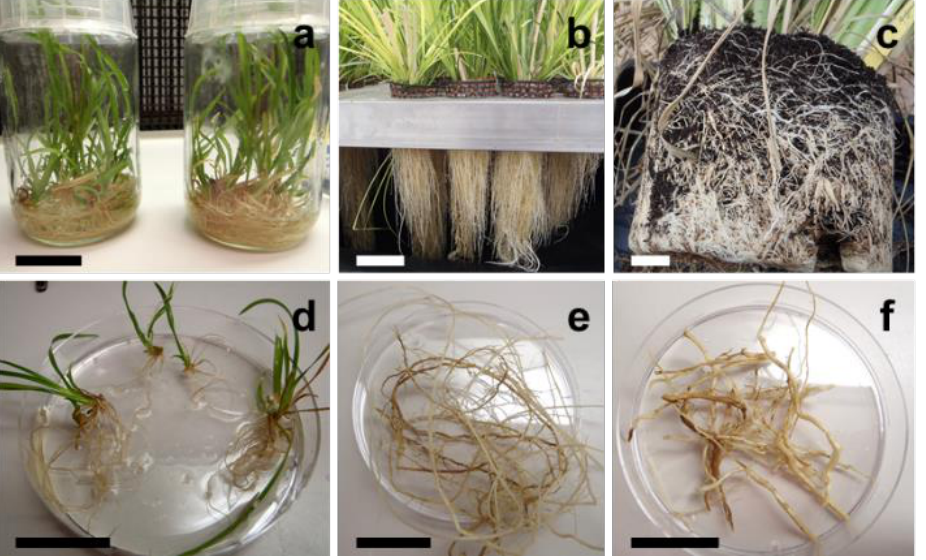
Figure 1. ( a – c ) Root systems and ( d – f ) root samples of vetiver grown ( a , d ) in vitro, ( b , e ) in high- pressure aeroponics (HPA), or ( c , f ) in potting soil. Bars represent ( a ) 3 cm, ( b ) 10.5 cm, ( c ) 4.8 cm, and ( d – f ) 3 cm.